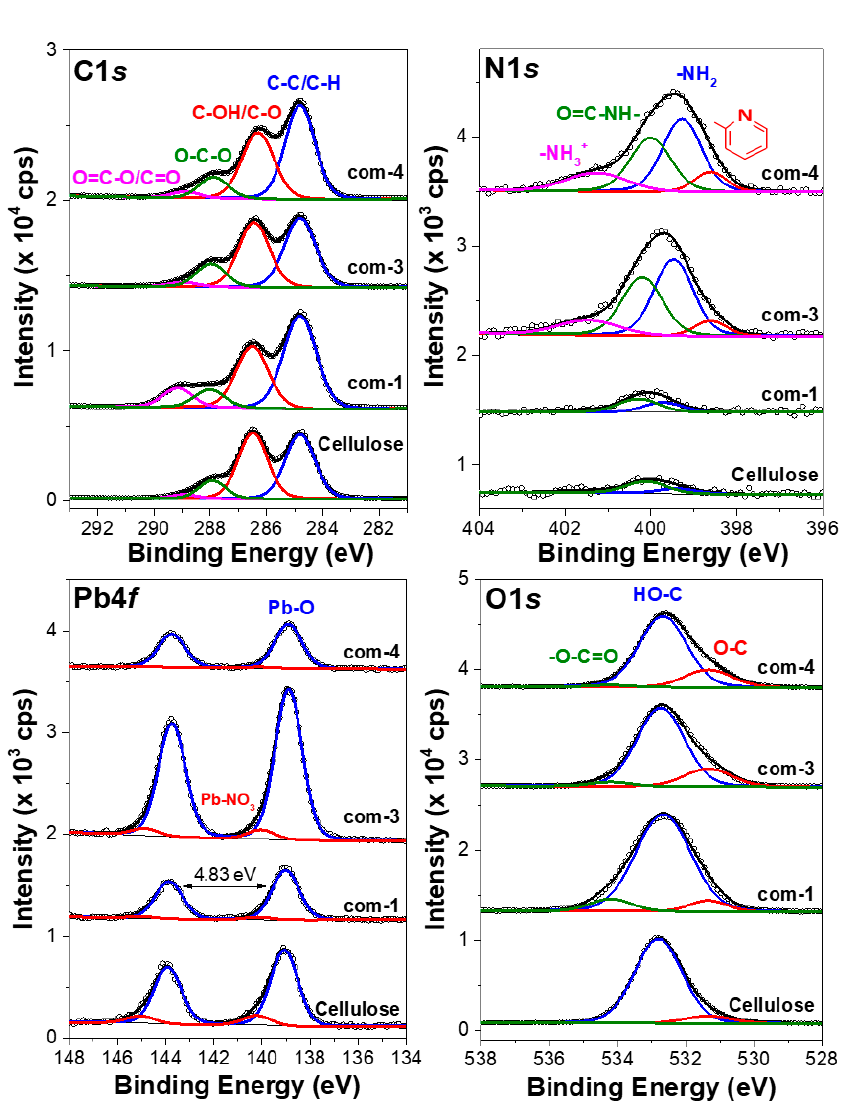
Figure 4. XPS high-resolution spectra of core levels of C 1 s , N 1 s , Pb 4 f , and O 1 s for cellulose, Com-1, Com-3, and Com-4 derivatives.